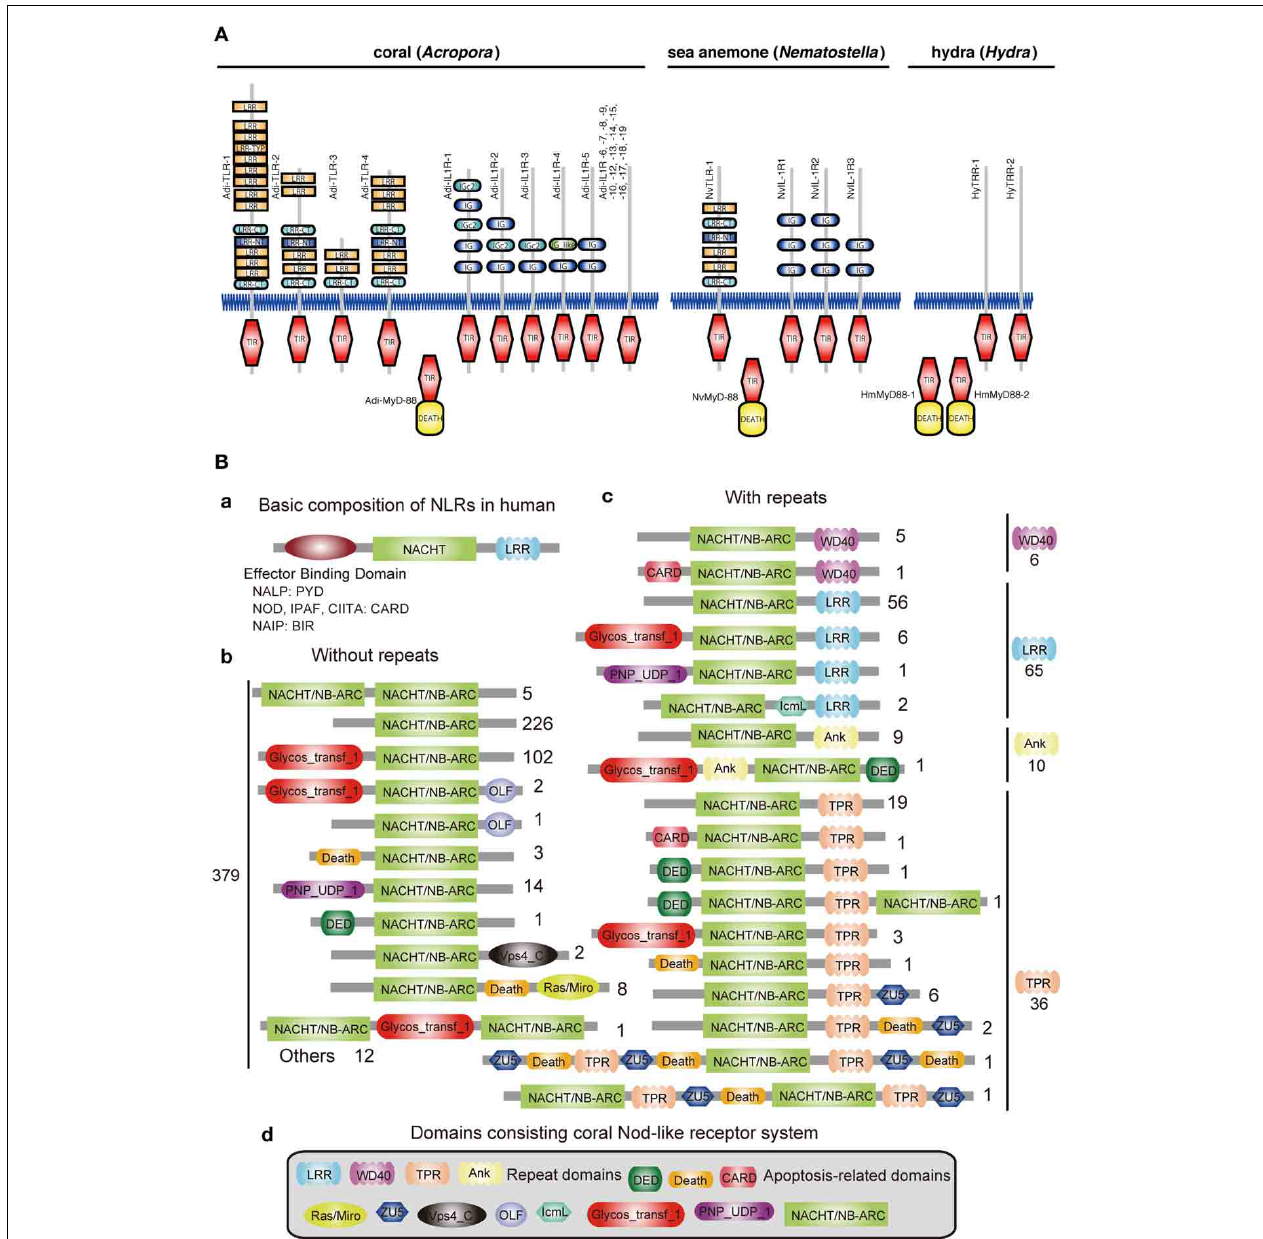
FIGURE 3 | Innate immunity of corals. (A) Repertoires of TIR domain-containing proteins of three cnidarians. The schematic representation of the domain structures of all of the TIR domain-containing proteins identified in Acropora digitifera , alongside the corresponding complements from Nematostella vectensis and Hydra magnipapillata . The repertoire of Toll/TLR, IL-1R-like, and TIR-only proteins is significantly more complex in the case of A. digitifera than in N. vectensis or H. magnipapillata . TIR, TIR domain; DEATH, DEATH domain; IG and IGc2, Ig domain; LRR, LRY-TRY, LRR-CT and LRR-NT, leucine-rich repeats. (B) The complexity of the NBD repertoire of